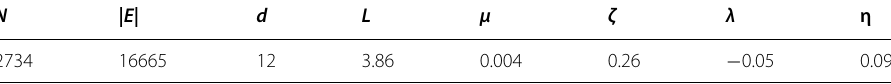
N is the network size. | E | is the number of edges. d is the diameter. L is the average shortest path length. µ is the density. ζ is the transitivity also called global clustering coefficient. (cid:31) is the assortativity also called degree correlation coefficient. η is the hub